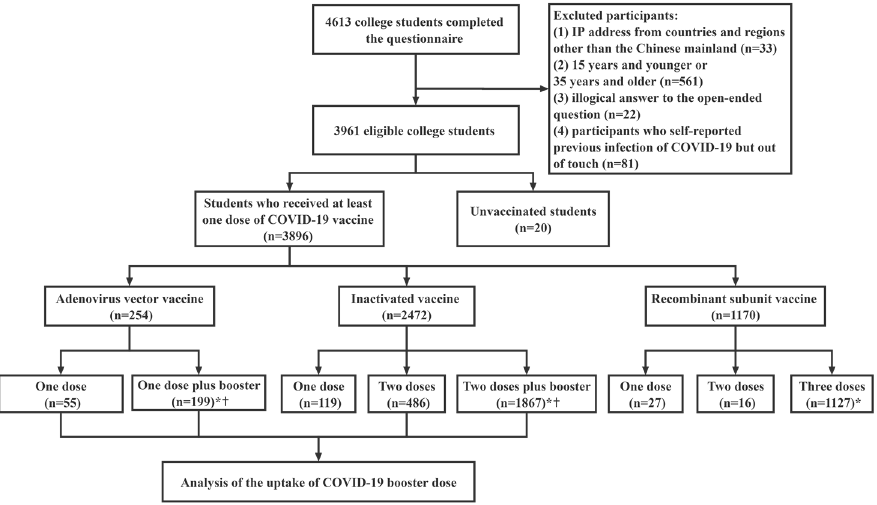
Figure 1. Flow chart of selection and analyses of the study respondents. * refers to the respondents who have completed vaccination. † refers to the respondents who have received a booster dose. Table 1. Characteristics of respondents (N =